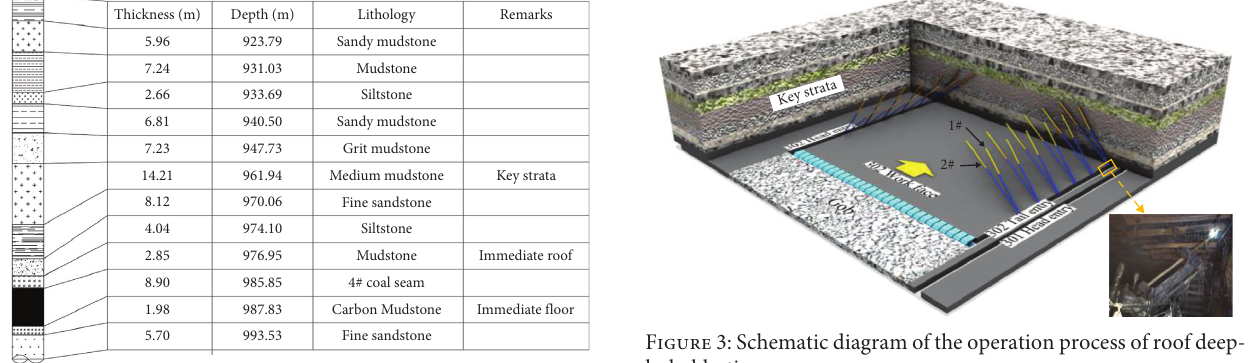
Figure 2: Comprehensive histogram of strata.